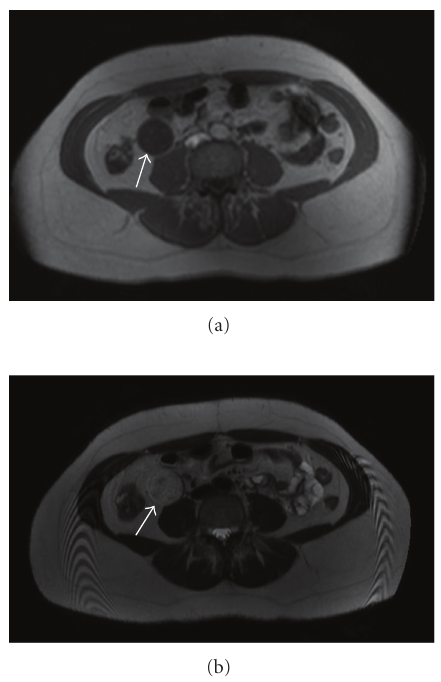
Figure 2: The retroperitoneal mass is hypointense on T1W (a) and heterogeneously hyperintense on T2W (b) MRI images.